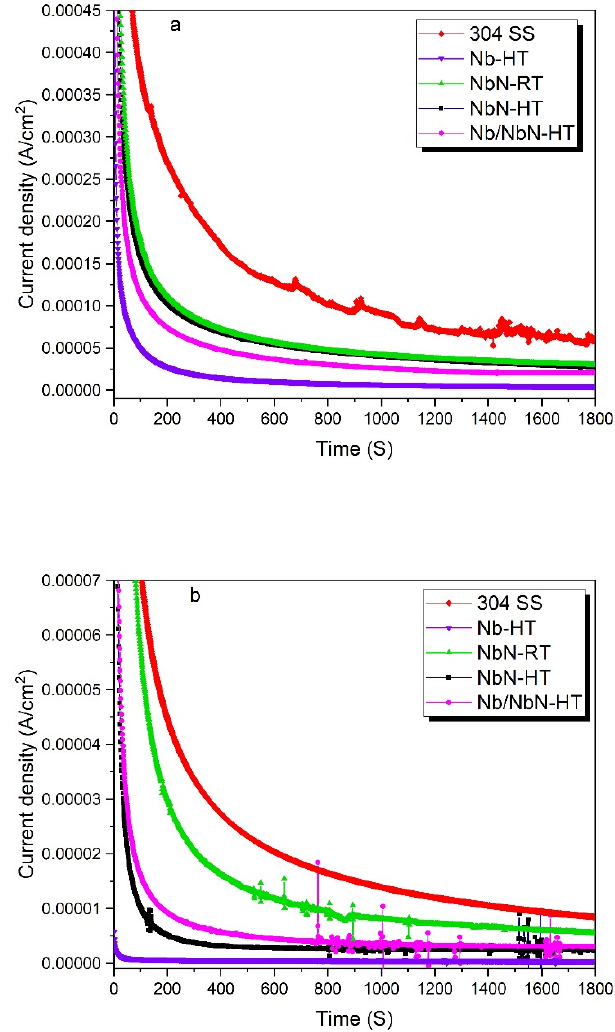
Figure 9. Potentiostatic polarization behavior for the uncoated 304 substrate and di ff erent coatings in 1 M H 2 SO 4 + 2 mg / kg HF solution and 70 ◦ C at ( a ) simulated cathode ( + 0.644 V vs. Ag / AgCl) and ( b ) simulated anode ( − 0.056 V vs. Ag / AgCl). Table 9. Stable current density of coated and bare 304 stainless steel after potentiostatic measurements for 30 min.